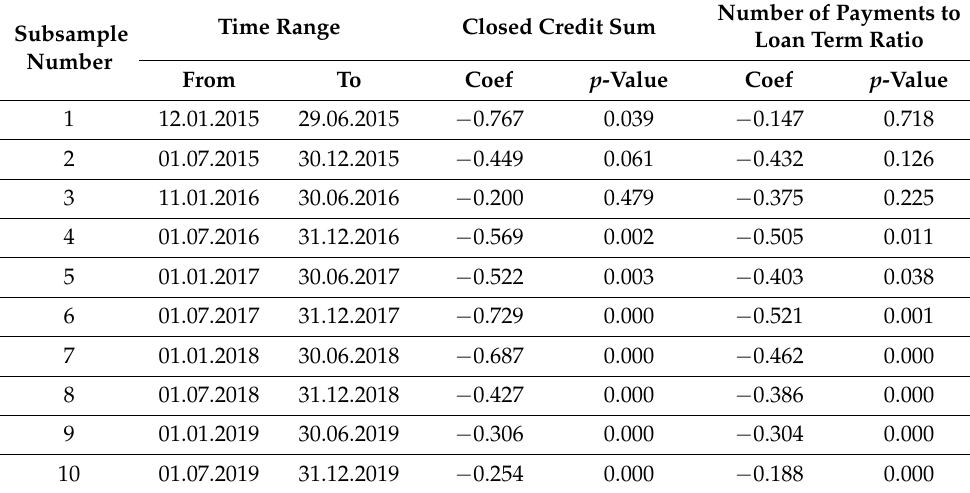
Table 1. Coefficients’ dynamics for a two-factor logit model.